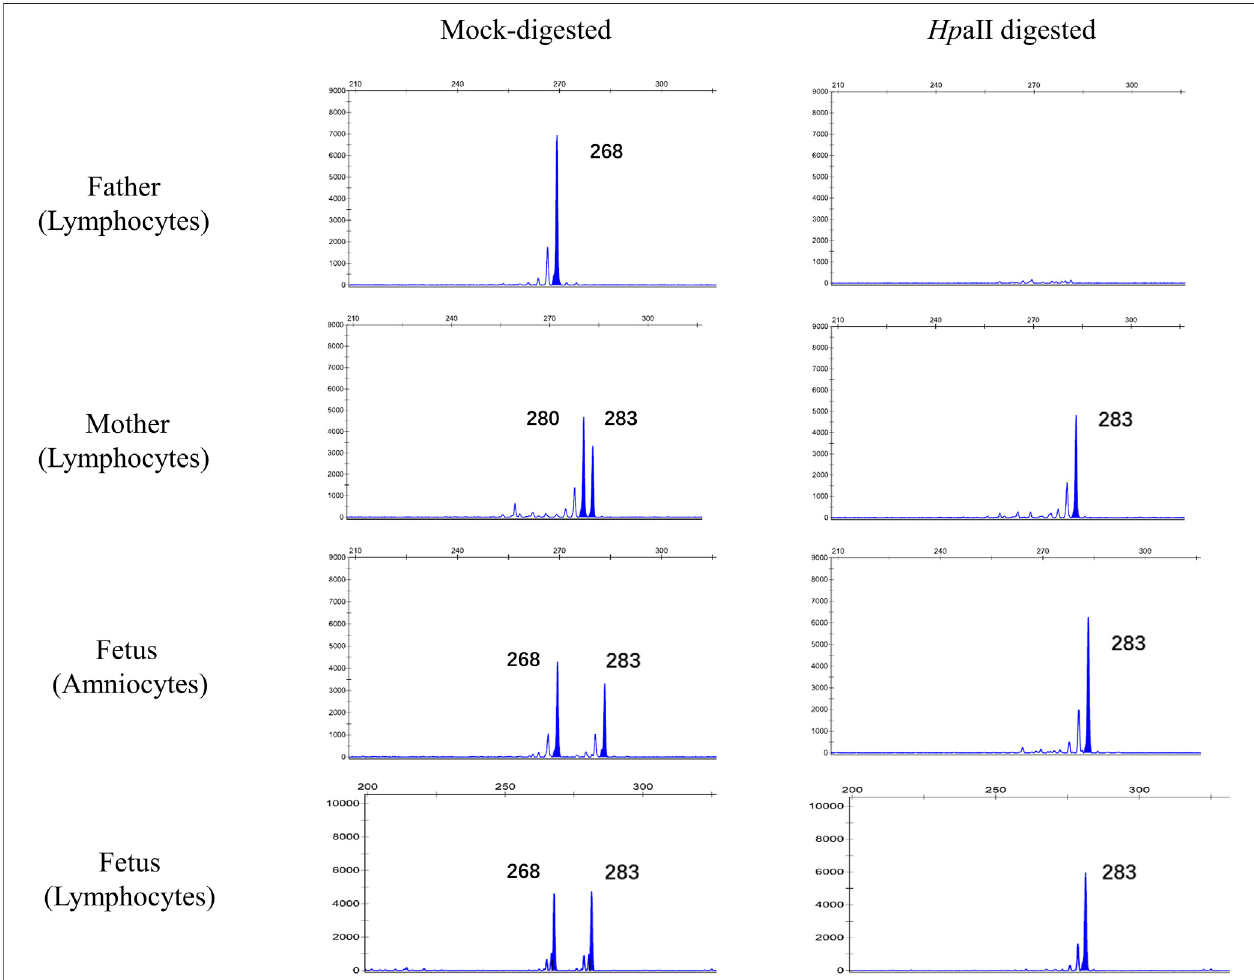
FIGURE 2 | Prenatal XCI assay performed in the female fetus of pedigree 1. gDNA extracted from fresh uncultured amniocytes of the fetus and peripheral blood lymphocytes of her parents was used to detect 5meCpG statuses of AR and RP2 alleles. The peaks indicate the informative AR alleles. The size of each allele is determinedbythelengthofpolymorphicmicrosatelliteintheexon1of AR gene.Theallele 268 andallele 283 ofthefetusisinheritedfromherfatherandmother,respectively. After digestion by methylation-sensitive Hpa Ⅱ restriction endonuclease, bi-allelic status of the mother and fetus ’ s AR gene converts to a mono-allelic status, which means that both of them possess completely skewed XCI pattern and the remaining alleles represent the alleles that have been inactivated (methylated). Thus, for the fetus, skewed XCI towards allele 283 of her, which indicates the maternal-original X chromosome (the one taking microdeletion), has been inactivated. The XCI pattern of amniocytes is perfectly replicated in neonatal cord blood lymphocytes.